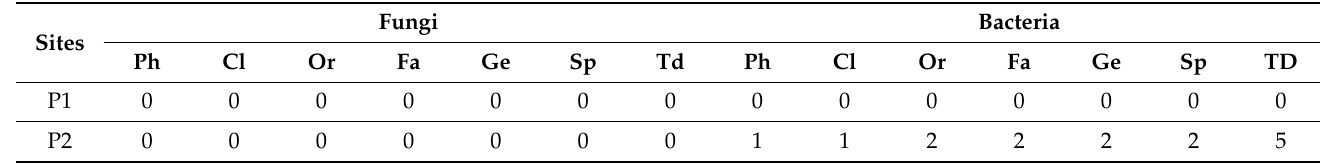
Table A1. Species classification of fungi and bacteria based on the detection results obtained from 36 study